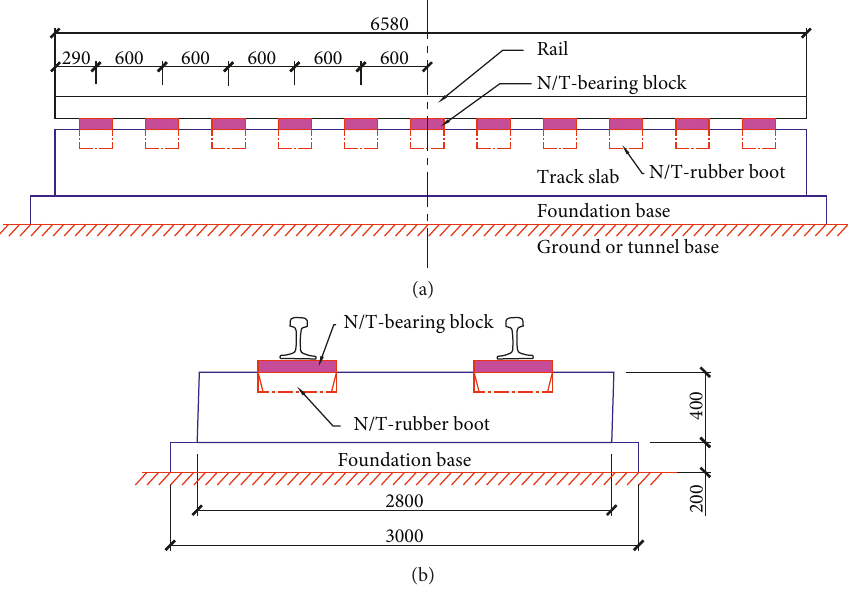
Figure 3: Full-scale test model design maps (unit: mm). (a) Front view. (b) Side view.